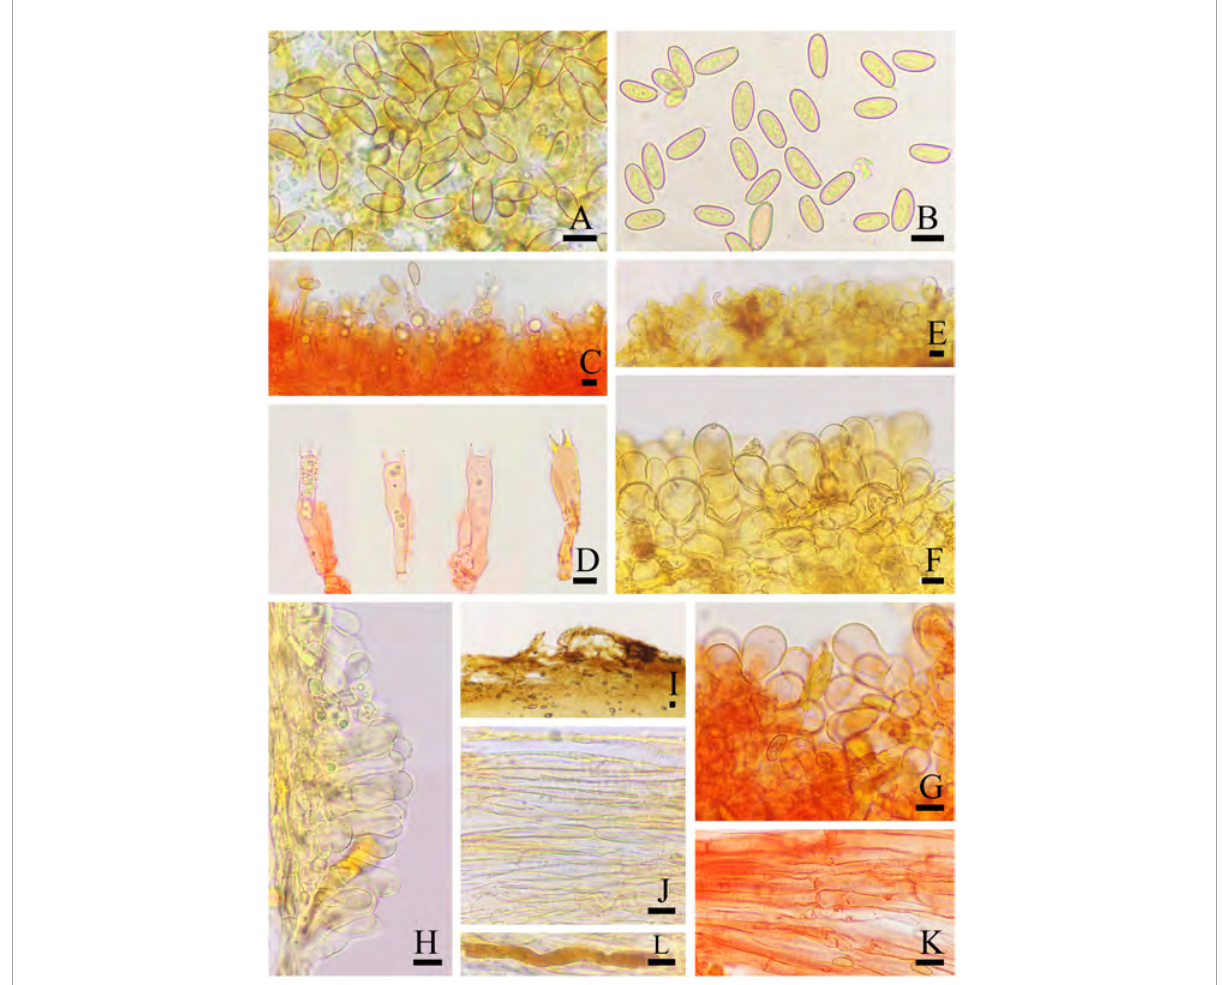
FIGURE7 Microscopic features of Inosperma longisporum (MHHNU32337, holotype). (A,B) Basidiospores; (C,D) basidia with probasidium; (E) gill edge; (F,G) cheilocystidia and paracystidia; (H) caulocystidia and cauloparacystidia; (I,J) pileipellis; (K) hymenial hyphae; and (L) oleiferous hyphae. Scale bars = 10 µ